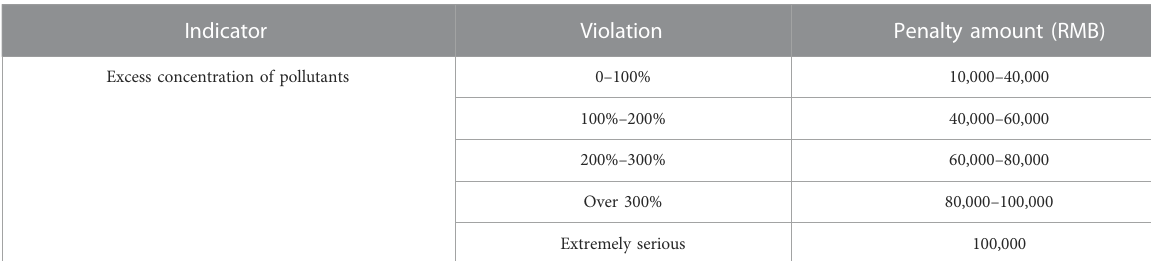
TABLE 3 Standardized discretion in article 48 6